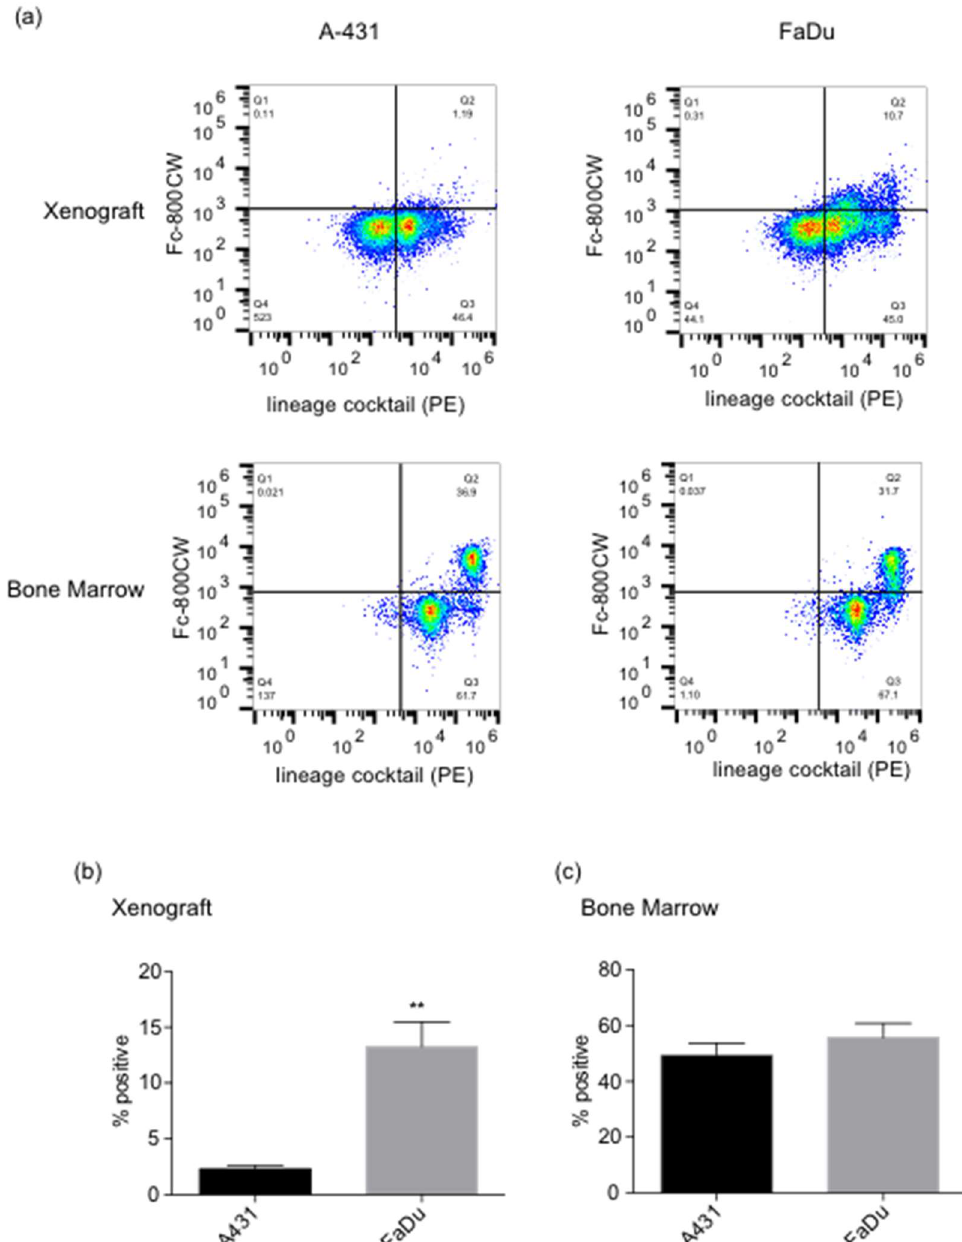
Figure 5. Flow cytometry analysis of cells collected from mouse xenografts and bone marrow. Tumor cells and bone marrow from CD-1 mice with A-431 and FaDu xenografts injected with IRDye800CW-Fc probe were collected, incubated with a lineage marker antibodies, and analyzed by flow cytometry. ( a ) Dot plot of representative flow cytometry with lineage markers and IRDye800CW-Fc probe. ( b ) Percent positive cells for Fc and Fc+ lineage marker in the xenografts. ** indicates p ≤ 0.01. ( c ) Percent of positive cells for Fc and Fc+ lineage marker in the bone marrow. Xenograft cells were stained with lineage markers for differentiated mouse blood cells and approximately half of cells collected stained positive for lineage markers. There were <0.5% IRDye800CW positive cells in the lineage negative gate. The majority of IRDye800CW positive cells were found in the lineage marker positive gate, indicating that the Fc domain probe was not binding tumor cells, but instead binding to mouse blood cells. Cells from the A-431 xenografts showed minimal staining (2.3 ± 0.3%) with the IRDye800CW-Fc domain compared to cells from FaDu xenografts, which showed signifi- cantly more (13.3 ± 2.2%, p = 0.01) lineage positive cells. Cells collected from the FaDu